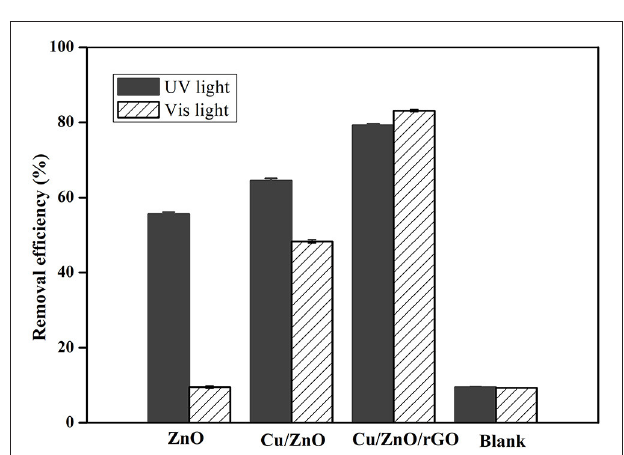
FIGURE 5 | Photocatalytic removal efficiency of NH + 4 -N under UV and Vis irradiation with no catalyst (blank), ZnO, Cu/ZnO, and